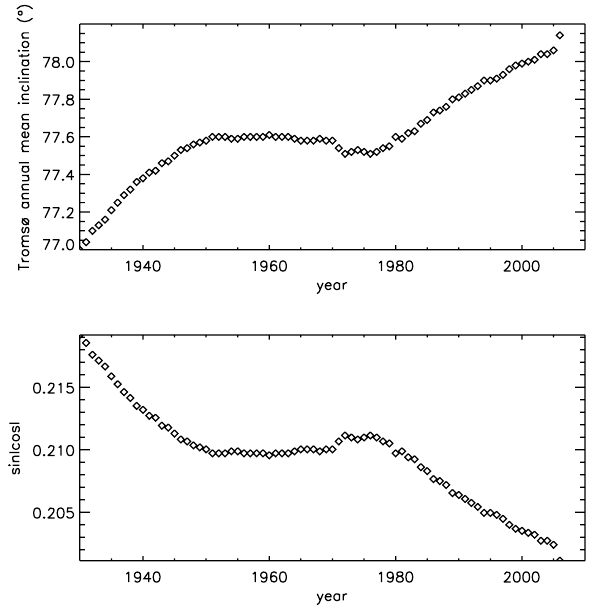
Fig. 8. Upper panel: geomagnetic inclination I at Tromsø; lower panel corresponding sin I cos I